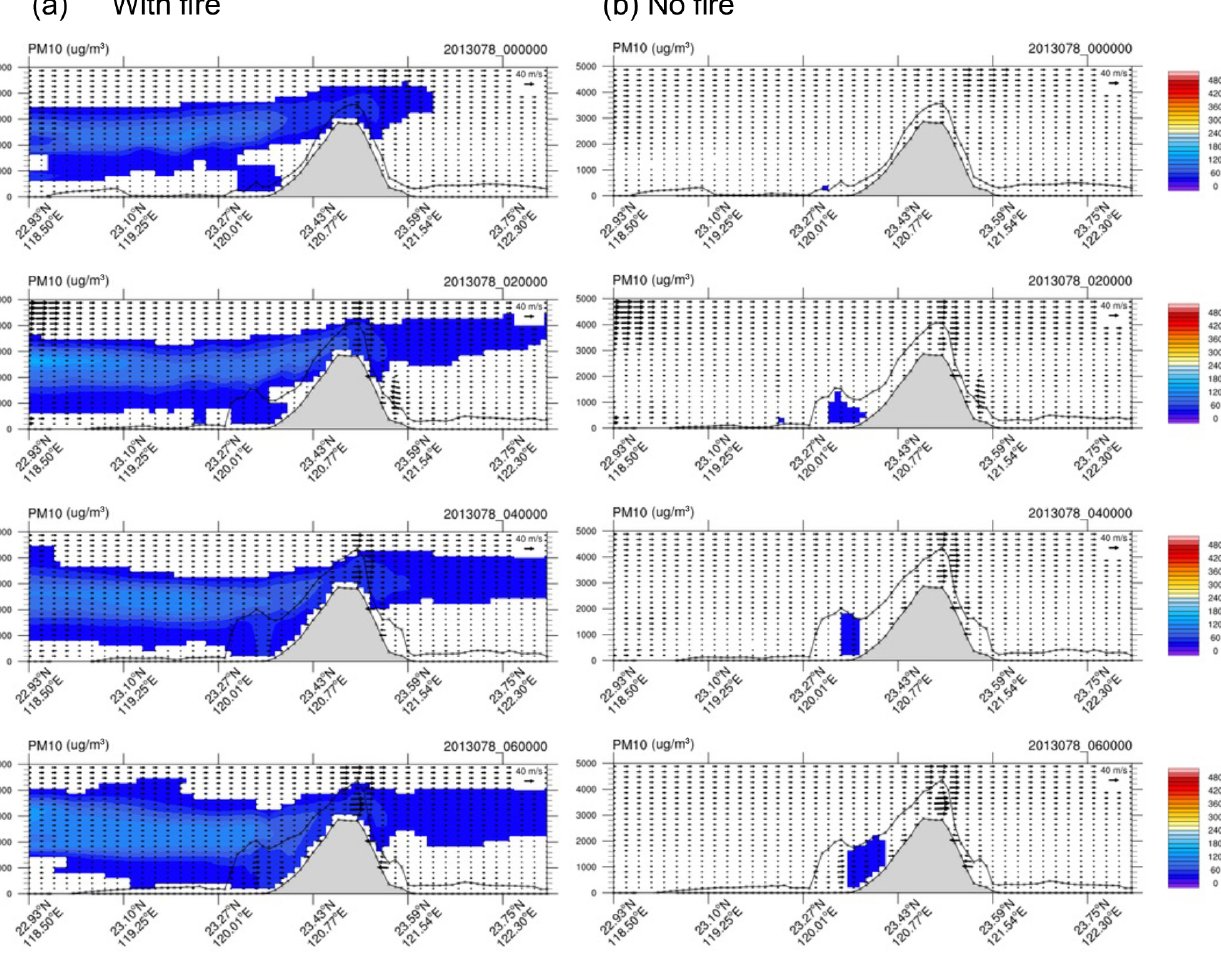
weather conditions, the dust can be lifted and transported downwind and concurrently be present with the BB